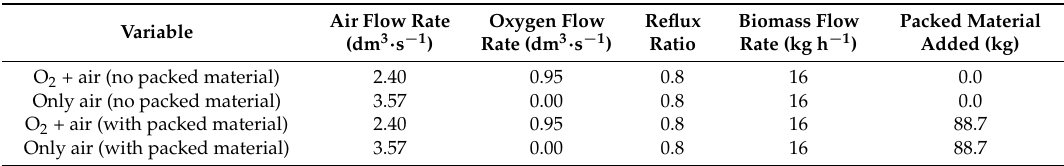
Table 2. Operational variables for the experiments carried out with a blend of oxygen and ambient air. Variable